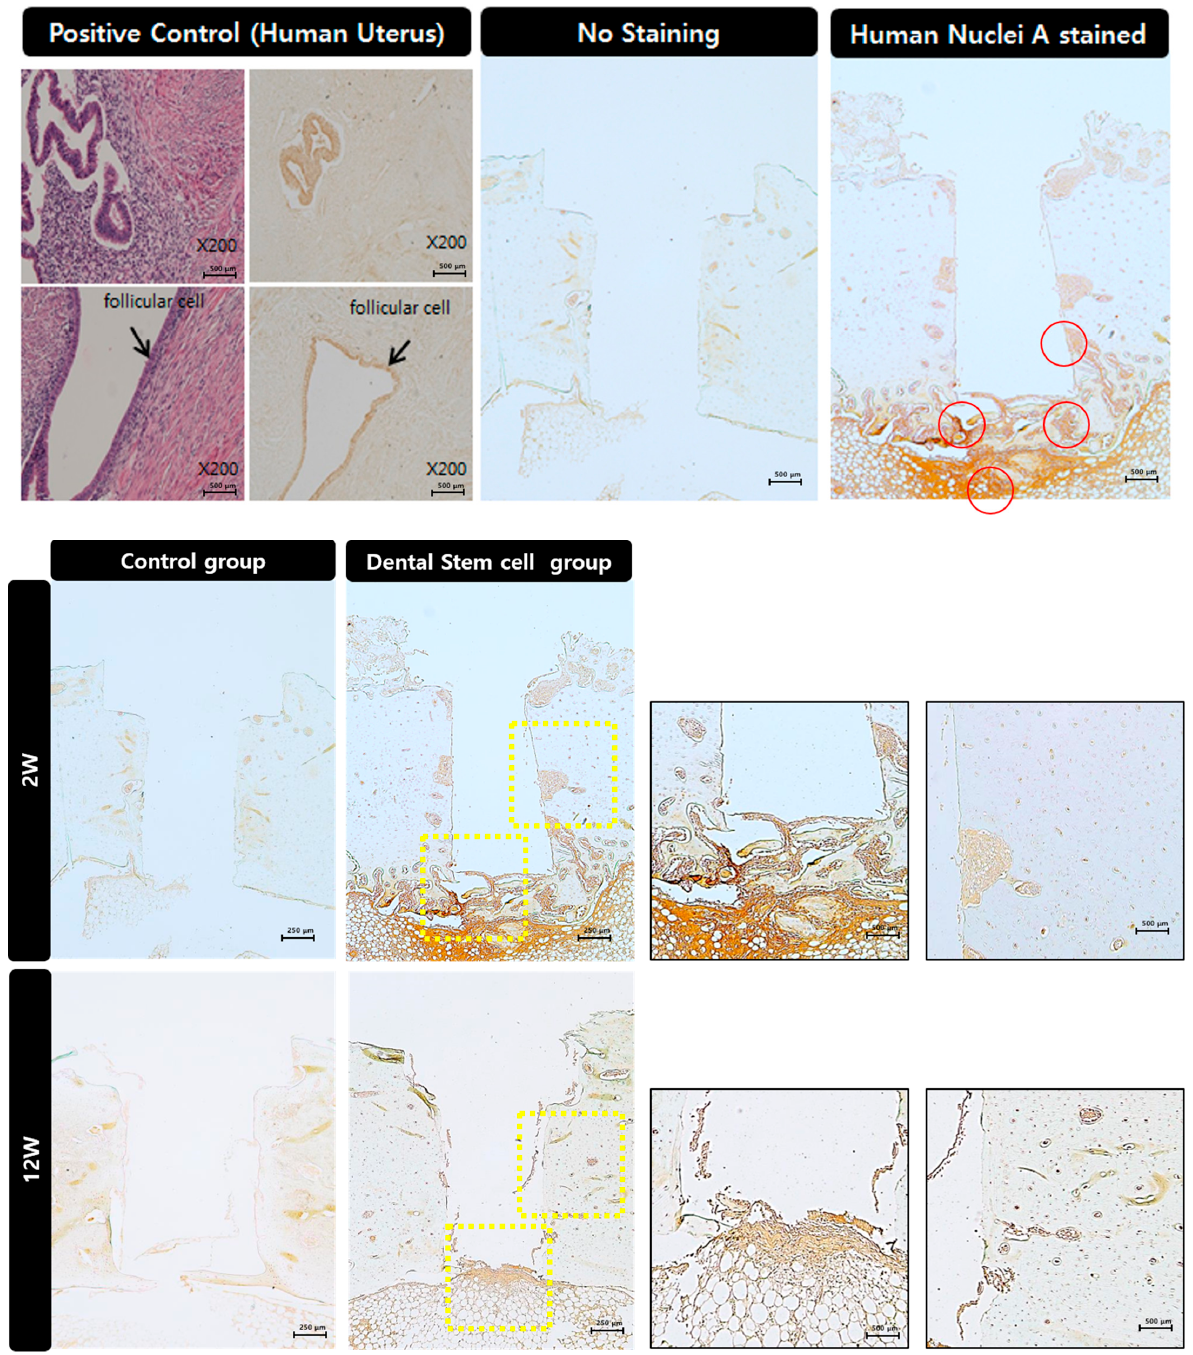
Figure 10. Immunohistochemical analysis of human nuclei A in the control group (without d-hMSCs) and the d-hMSCs group sacrificed at 2 and 12 weeks post-surgery (original magnification × 50, ×